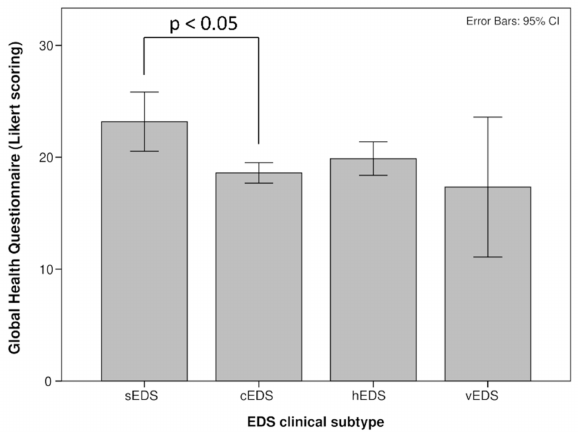
Figure 1. Global health questionnaire differences between EDS subtypes.